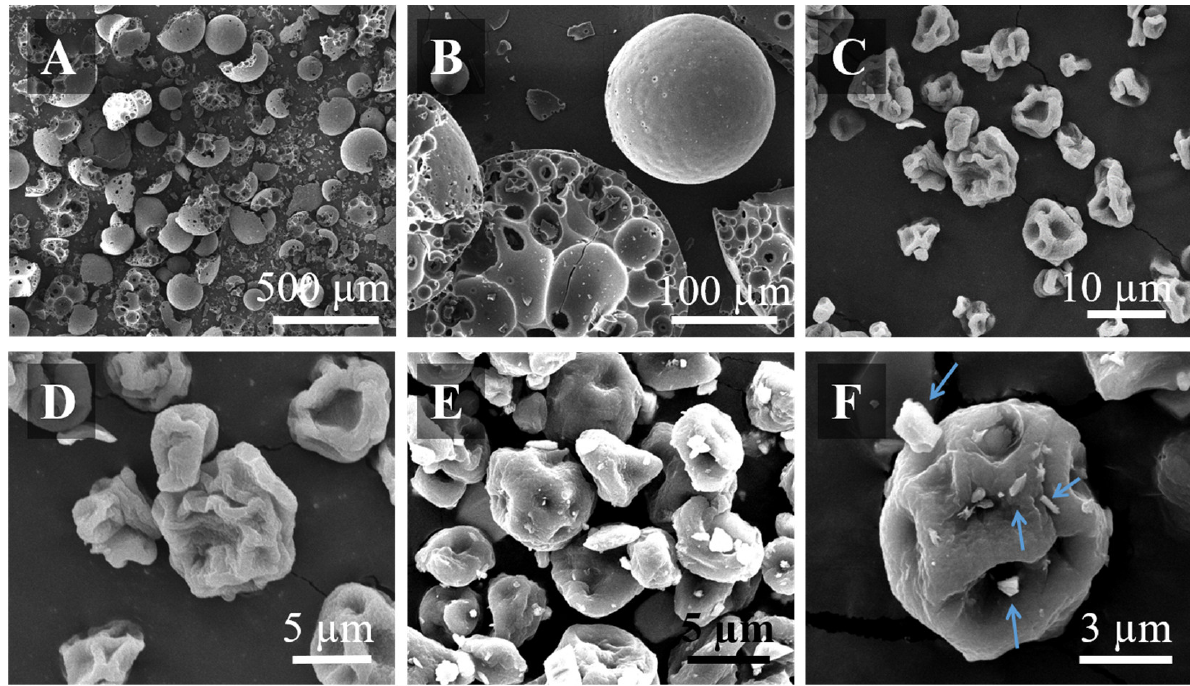
Figure 2. Images obtained by Scanning Electron Microscopy (SEM) of: ( A , B ) Raw Colistin Sulfate; ( C , D ) Alginate microparticles; ( E , F ) ALG@CLS MPs. CLS crystals are visible on the surface of the alginate microparticles (some are marked by blue arrows in Figure 2F).